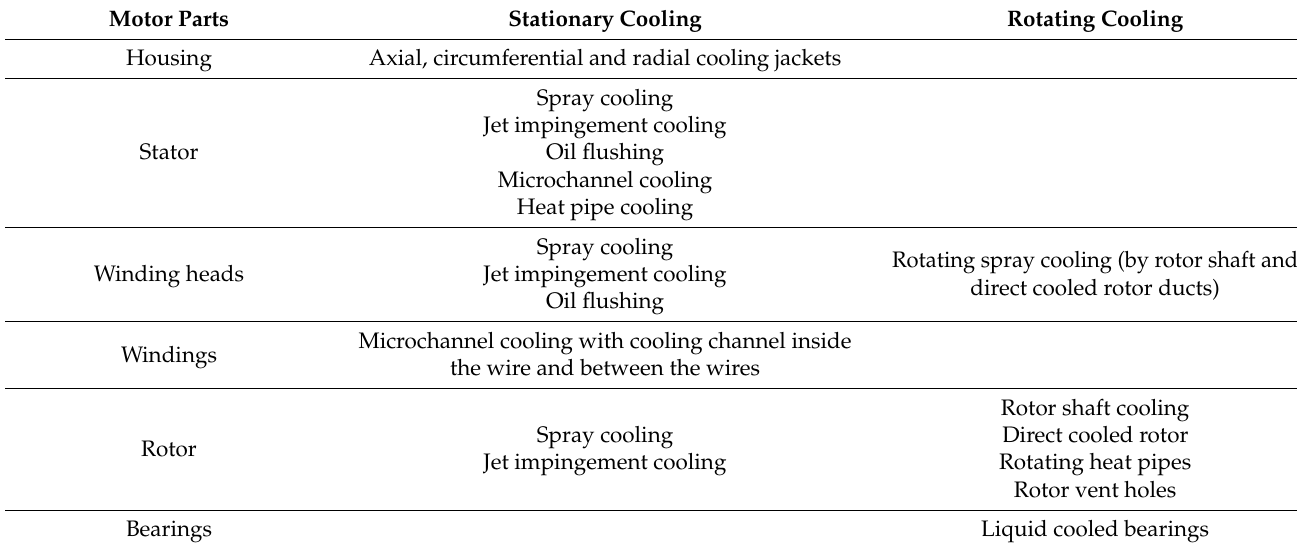
Table 1. Cooling concepts in the thermal motor